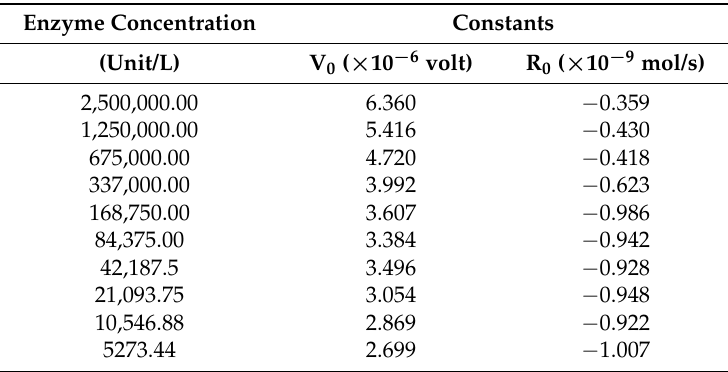
Table 3. Value of V 0 and R 0 in Equation (2).